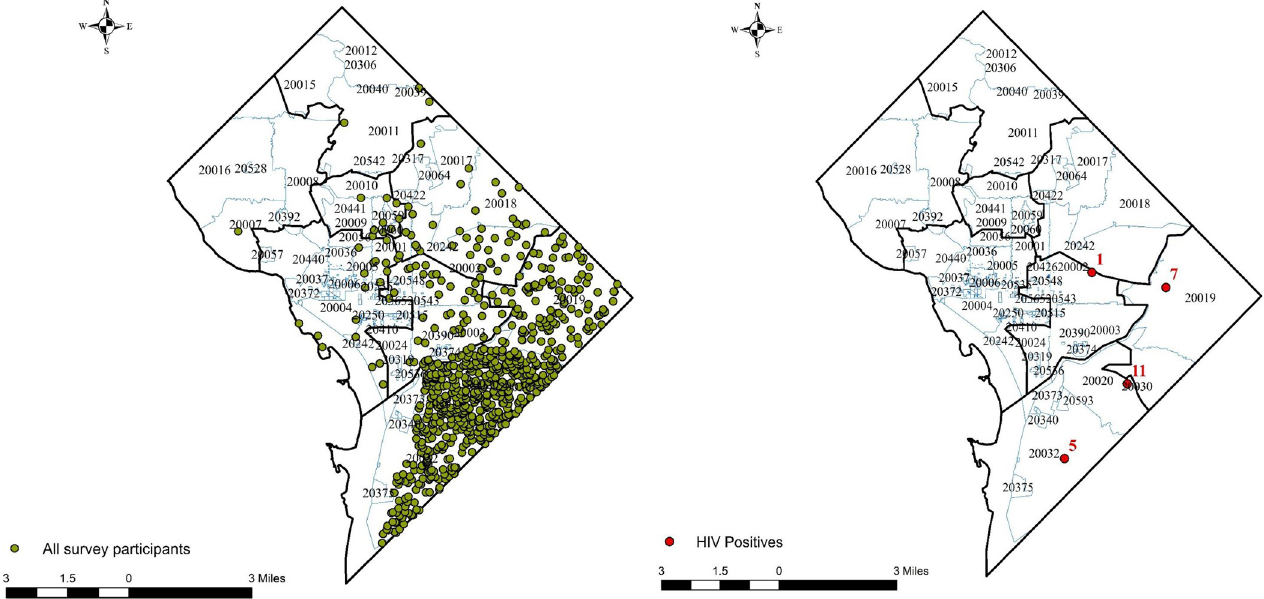
Fig 1. Distribution of HET4 cycle participants and HIV positives in DC. The green dots show the distribution of the survey recruitment. The numbers in red for HIV positives designate the total number of cases in zip code.